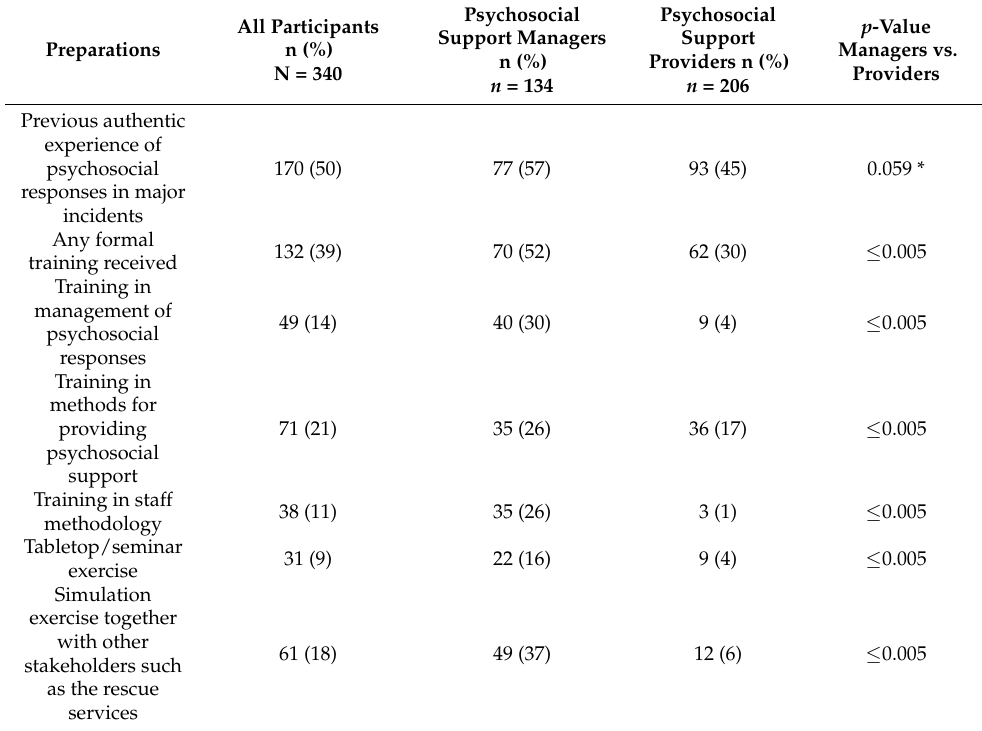
Table 3. Overview of